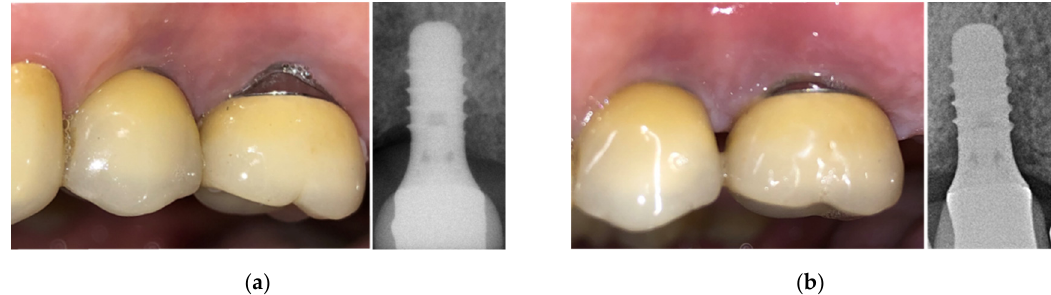
Figure 14. Clinical case No. 2: dental implant ( a ) before and ( b ) after the treatment.